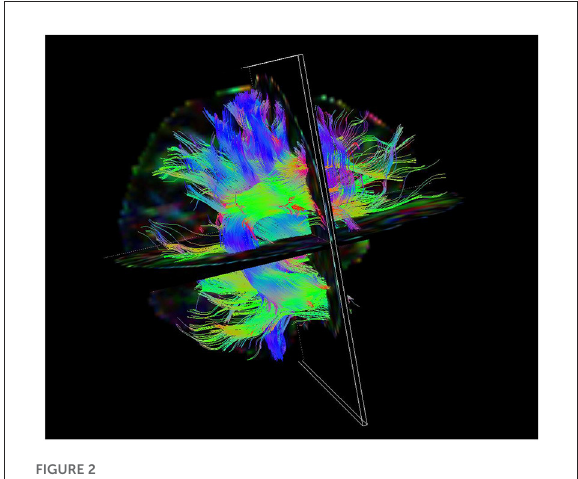
FIGURE2 Picture of white matter fiber bundle tracking results in patients with MMD by